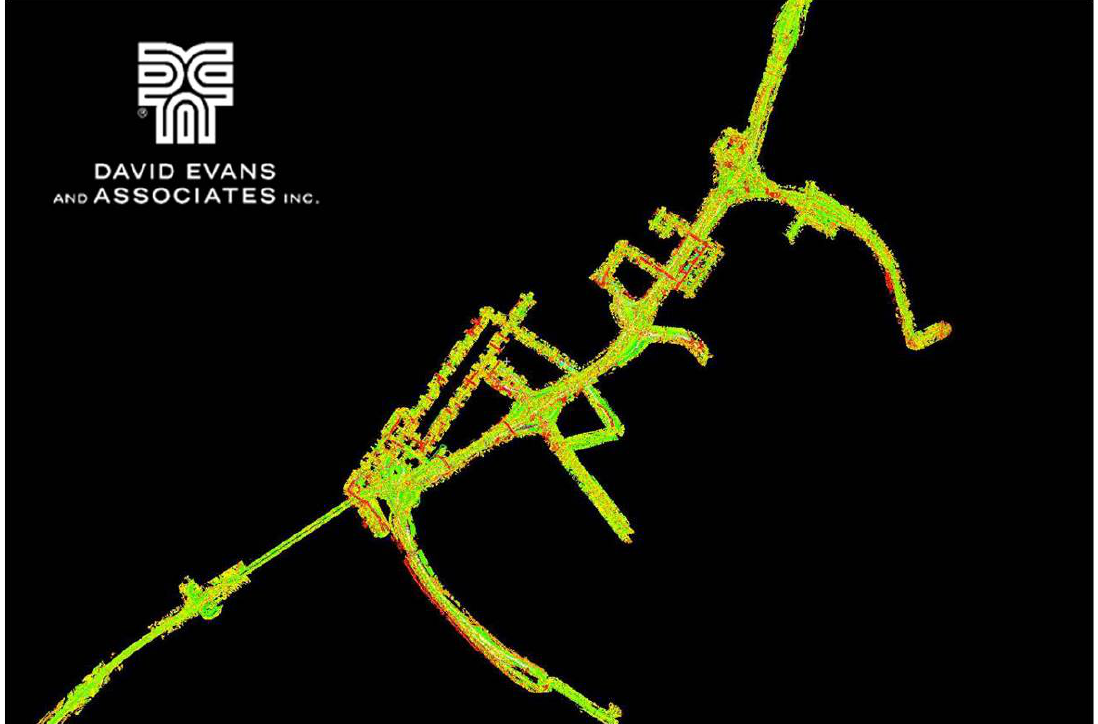
Figure 8. Plan view of a section of MLS data obtained for several arterial roads for the Columbia River Crossing Project, a comprehensive industrial, residential, and infrastructure redesign centered on the I-5 Bridge crossing the river. (Courtesy of